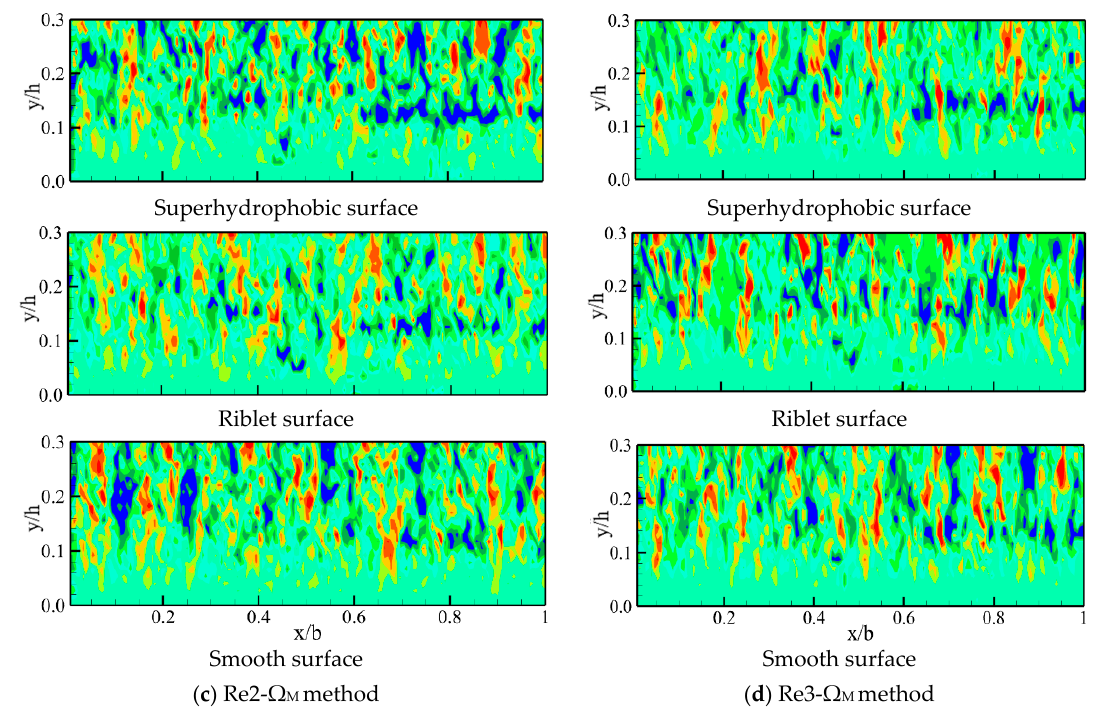
Figure 7. Vortex distribution near different surfaces at different Reynolds numbers. Note: Re1, Re2, and Re3 are the Reynolds numbers of 85,900, 120,260, and 137,440, respectively.